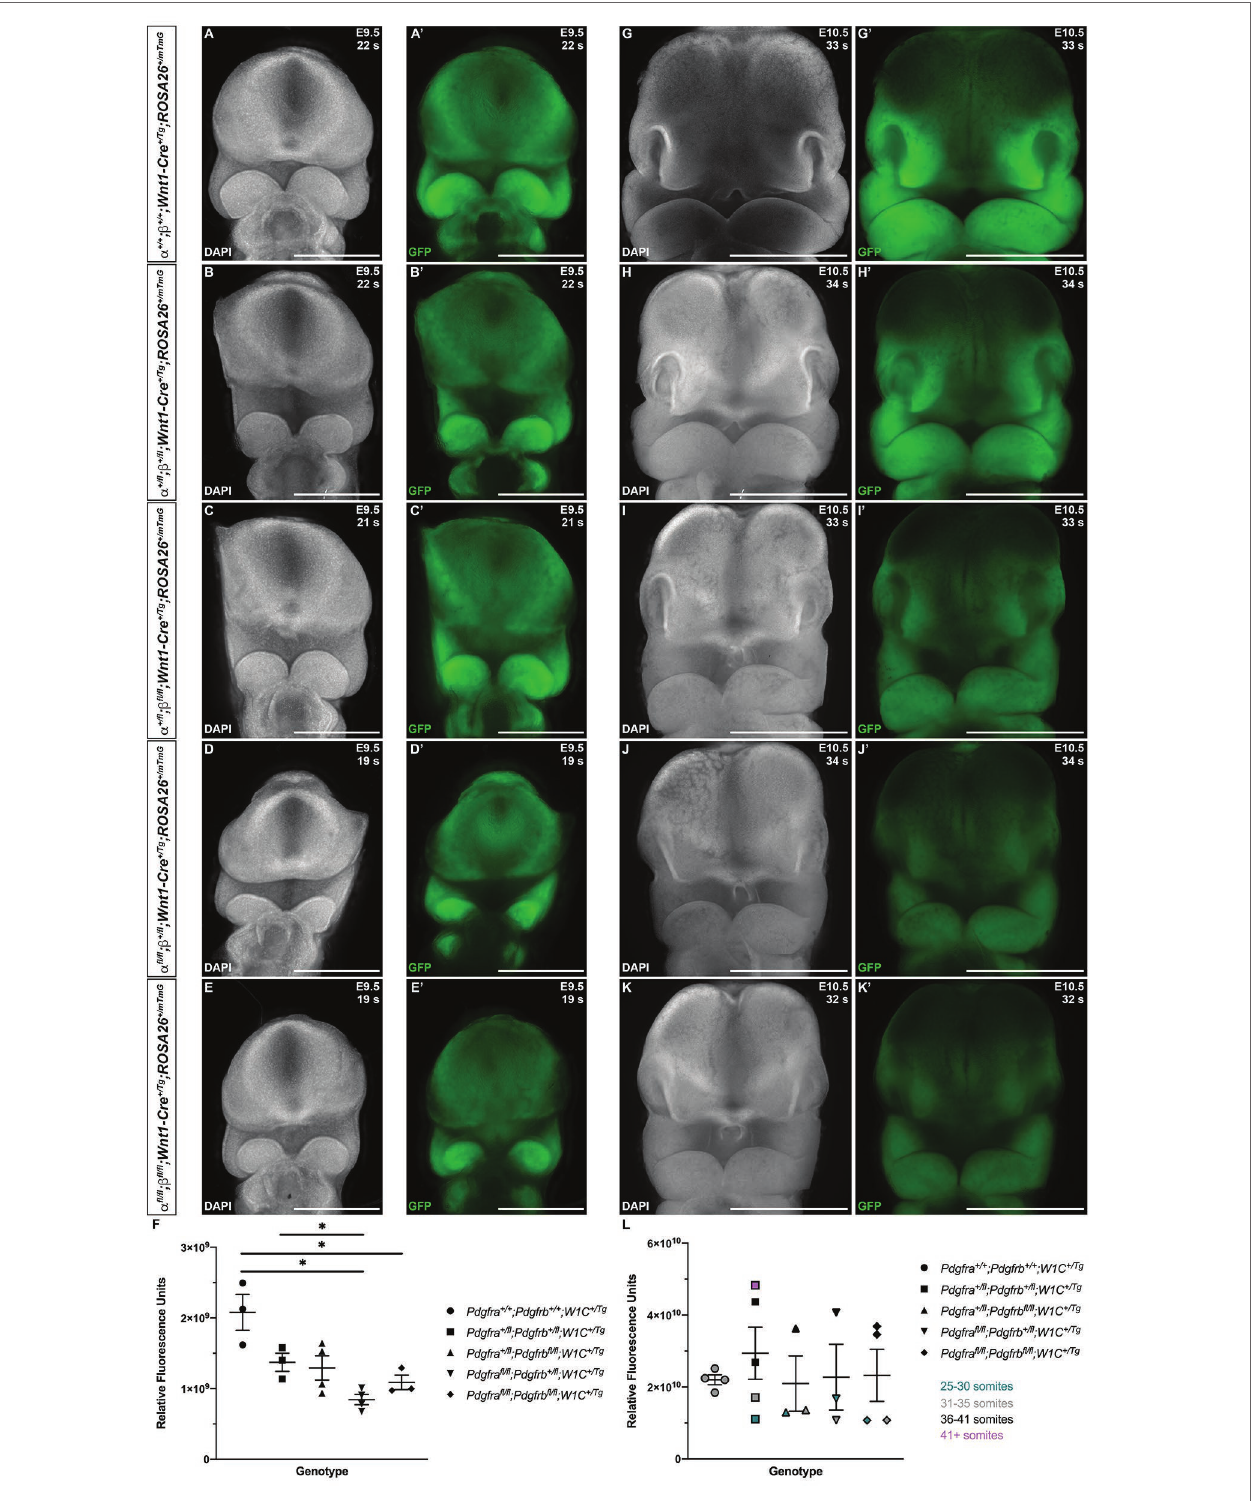
FIGURE 6 | Ablation of Pdgfra and Pdgfrb in the NCC lineage leads to decreased NCC derivatives in the facial prominences at mid-gestation. (A–K ' ) Frontal, whole-mount fluorescence images of DAPI (A–E,G–K) and GFP (A ' –E ' ,G ' –K ' ) expression across five genotypes at E9.5 (A–E ' ) and E10.5 (G–K ' ) . (F) Scatter dot plot depicting GFP fluorescence intensity across five genotypes at E9.5. Data are presented as mean ± SEM. * p < 0.05. (L) Scatter dot plot depicting GFP fluorescence intensity across five genotypes at E10.5. Data are presented as mean ± SEM. Colors correspond to number of somite pairs in assayed